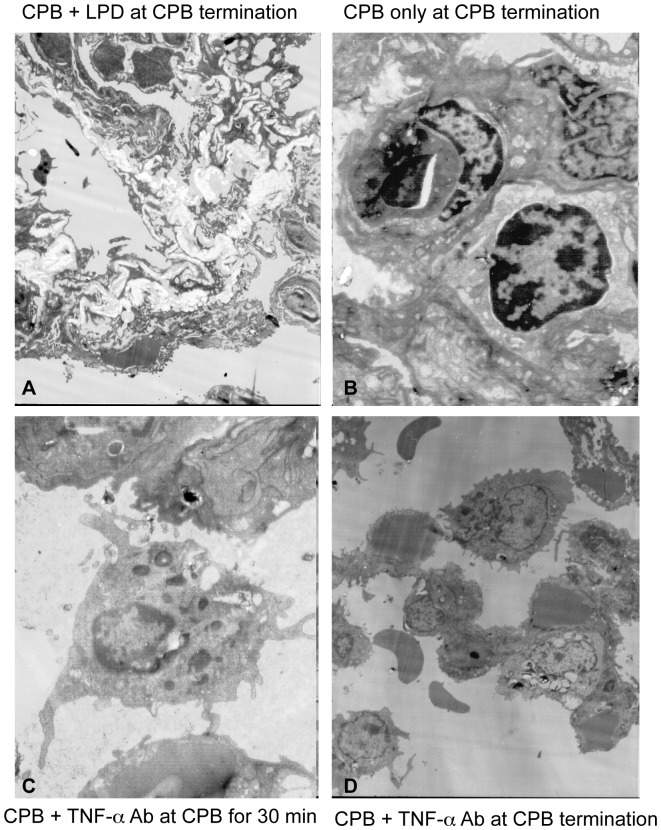
Pulmonary artery perfusion with TNF-α Ab alleviated CPB-induced histopathological changes in lung tissue.Lung tissue specimens from rabbits of group I (A), group II (C & D), and group III (B) were examined by transmission electron microscopy (JEM-1200EX II TEM, JEOL, Japan). The illustrated images (4000x) are the representative images.